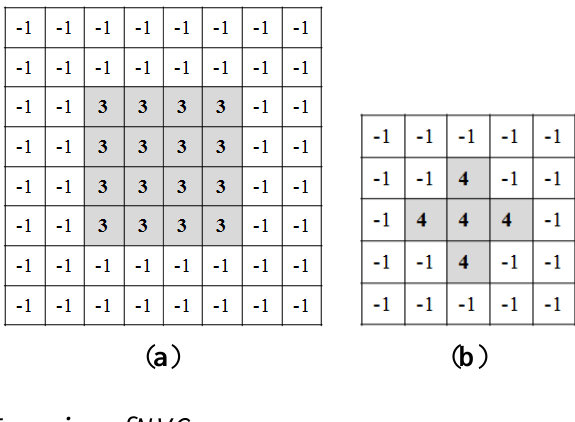
Figure 8. Convolution kernels for measuring focus score. ( a ) Daugman’s kernel [27]. ( b ) Kang’s kernel